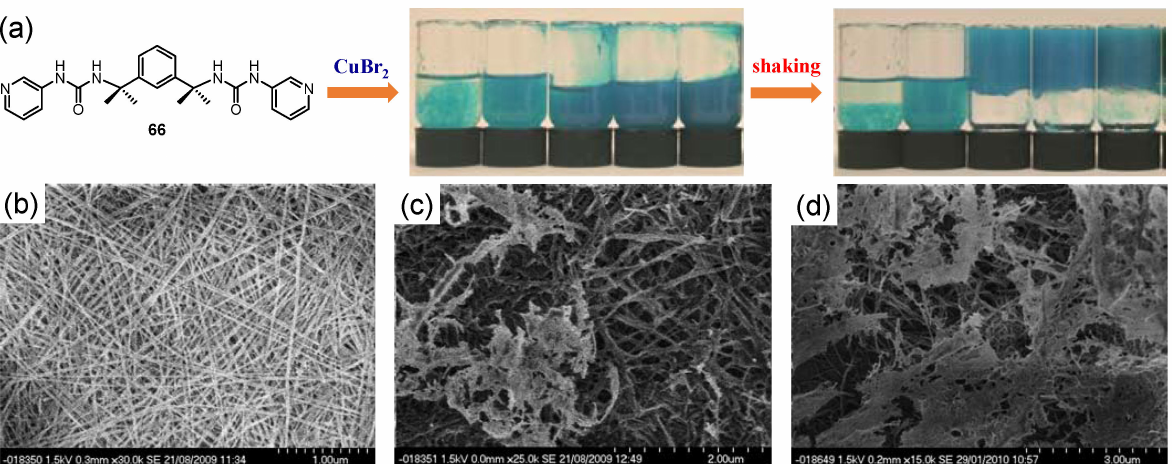
Figure 27. ( a ) CuBr 2 metallogels of ligand 66 (1 wt%) in MeOH using (from left to right in each picture) 0.1, 0.2, 0.3, 0.4 and 0.5 equivalents of CuBr 2 . The left-hand picture shows thick flowing liquids before shaking, and the right-hand picture shows the same samples after shaking and gelation of the 0.3, 0.4 and 0.5 systems. Cryo-SEM images of a gel sample of 66 in MeOH with 0.3 equivalents of CuBr 2 ( b ) before shaking, at − 100 ◦ C and ( c ) after shaking, at − 80 ◦ C, and ( d ) the shaken sample after 1 week of resting, at − 70 ◦ C. Reprinted with permission from Ref. [97]. Copyright (2010), Royal Society of Chemistry.